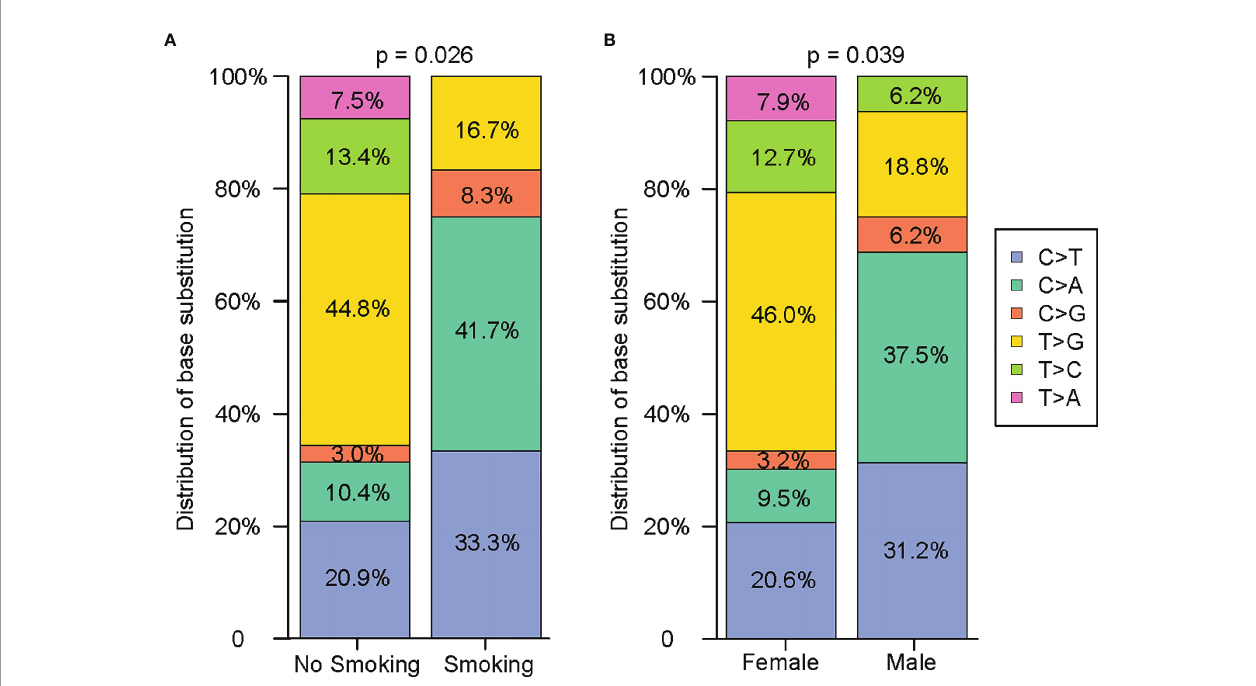
FIGURE 2 | Comprehensive analysis of the distribution characteristics of 79 single nucleotides on the basis of smoking history and sex. (A) Comparison of the difference in the single nucleotide variants between nonsmokers and smokers. (B) Comparison of the difference in the single nucleotide variants between females and